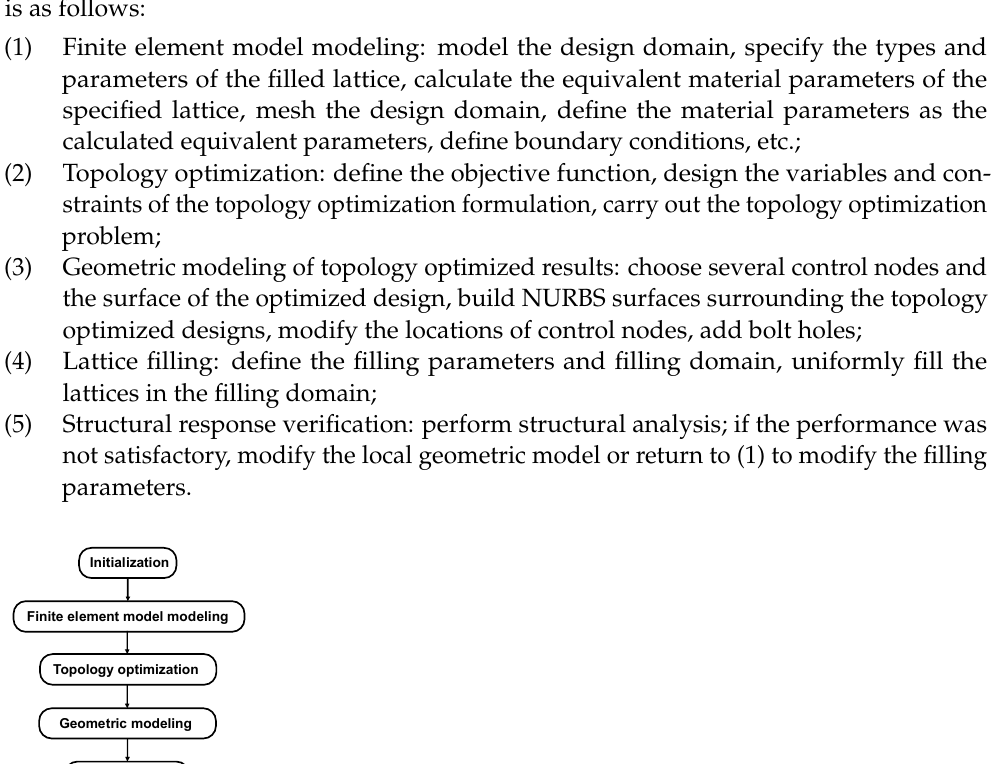
Figure 2. Structural responses of the initial design: ( a ) Displacement distribution in the axial over- load case; ( b ) Displacement distribution in the transverse overload case; ( c ) Vonmises stress distri- bution in the axial overload case; ( d ) Vonmises stress distribution in the transverse overload case.